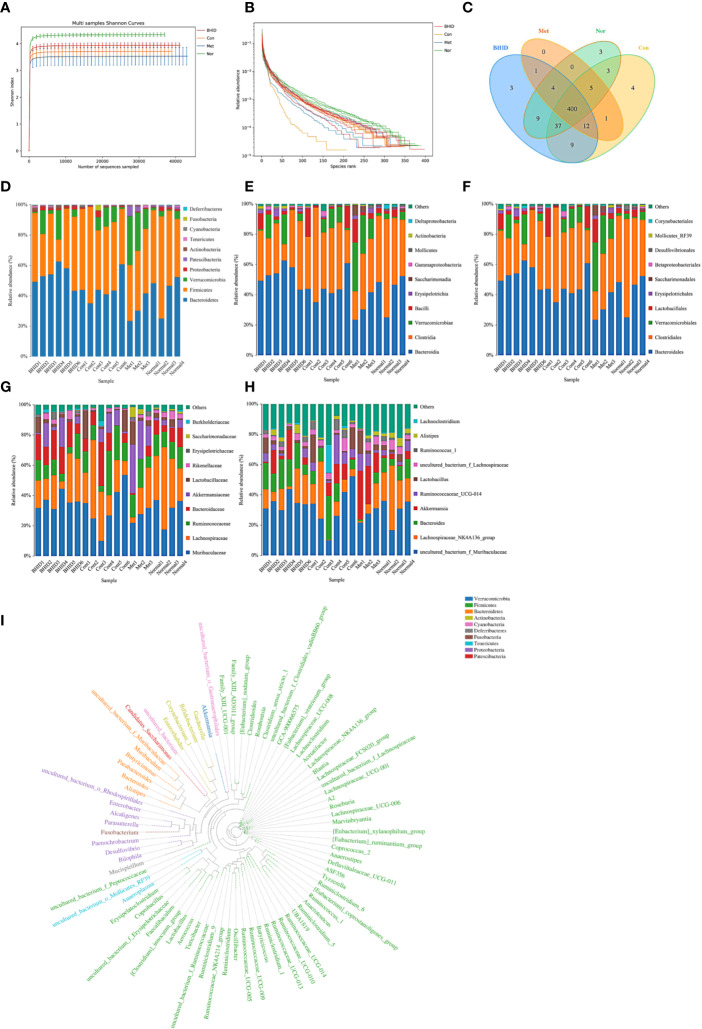
Overall structural modulation of gut microbiota. Shannon curves for all groups (A) and rank curves (B). Shared and special operational taxonomic unit (OTUs) for the normal, control, Bekhogainsam decoction (BHID), and metformin groups (C). The information of phylum, class, order, family, and genus level for each sample (D–H). The phylogenetic tree of OTUs at the genus taxonomic level (I). Nor, normal group; Con, streptozotocin (STZ)–induced diabetic nephropathy (DN) control group; BHID, BHID 500 mg/kg group; and Met, metformin 250 mg/kg group.